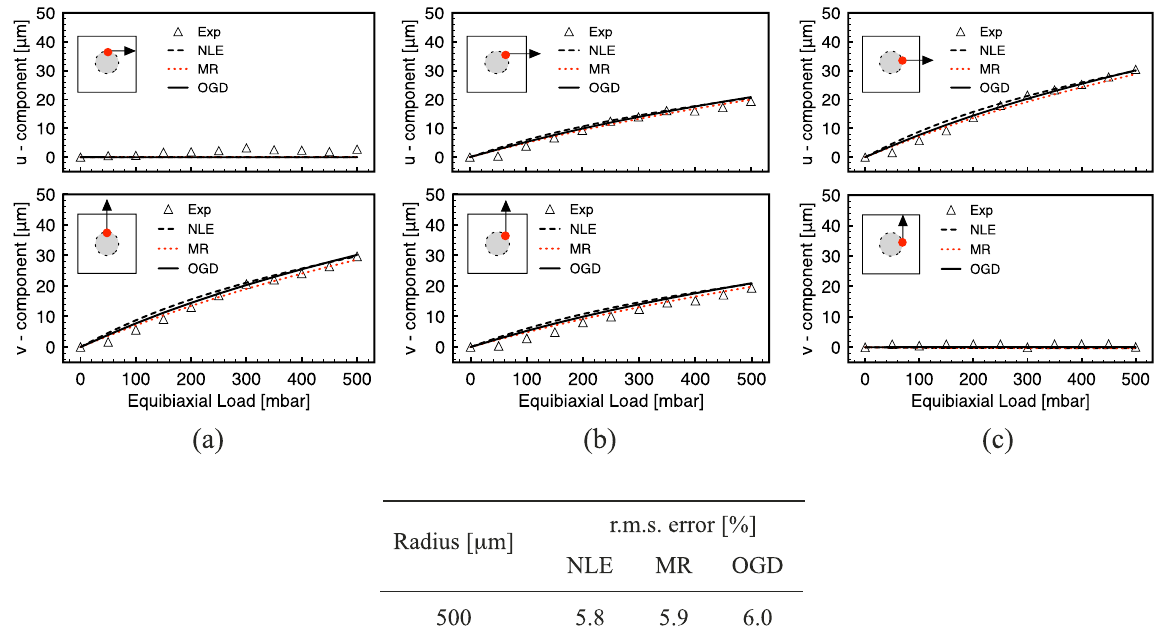
Figure 5. Model validation under equibiaxial loading (negative pressure). ( a–c ) Displacement field components (horizontal and vertical, u , v , respectively) taken at r = 500 μ m from the center of the PM for three representative points. ‘Exp’ refers to measured data as the mean of three independent experiments on different devices; NLE, MR and OGD refer to nonlinear elastic (7), Moonery-Rivlin (8) and Ogden (9) material models, respectively. The insets indicate the position of the points with coordinates (origin is set in the center of the membrane): ( a ) (0, 500), ( b ) (353, 353), ( c ) (500, 0). The table reports the average percentage error of the displacement for the three selected points for the peak pressure (500 mbar ) vs. the three material